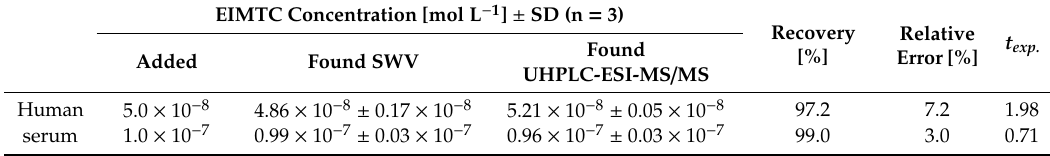
Table 2. Results obtained for EIMTC in human serum samples using SWV at the SPCE / CNFs and UHPLC-ESI-MS /